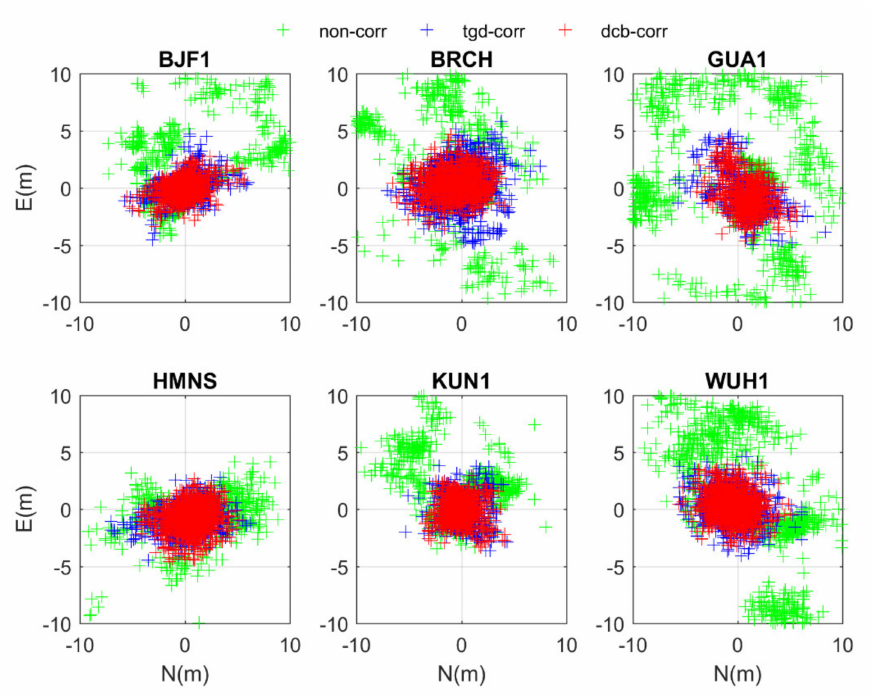
Figure 17. Horizontal positioning error scatters with and without TGD or DCB correction of B1C/B2a SPP at six stations.